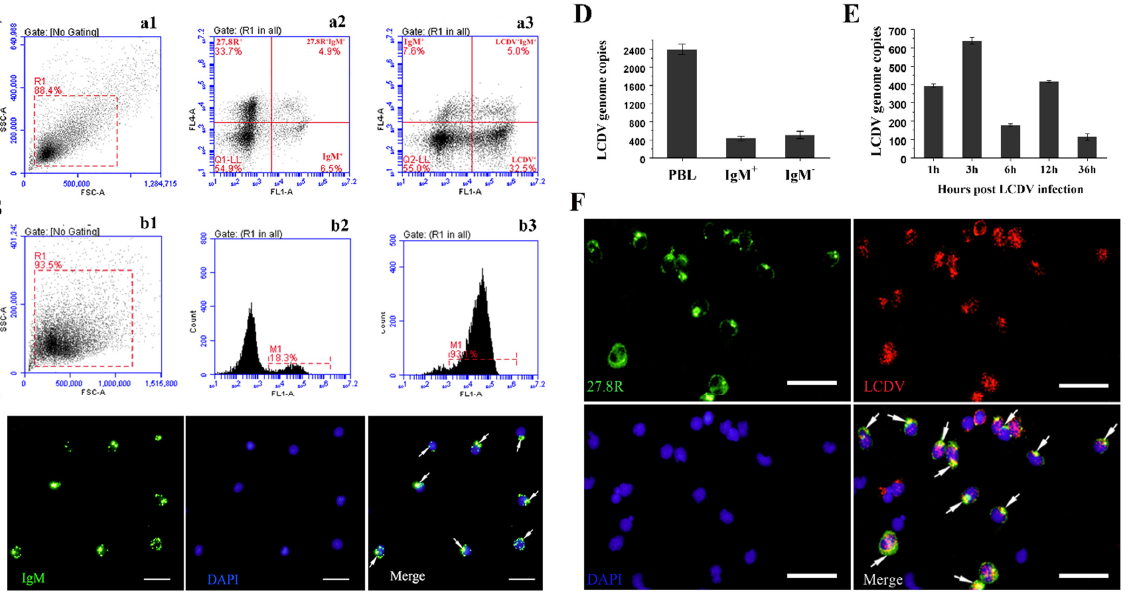
Figure 6. Flow cytometry analysis of 27.8R + /IgM + and LCDV + /IgM + cells in PBLs and LCDV detection and co-localization with the 27.8R in the sorted IgM + B-lymphocytes of flounder. ( A ) Flow cytometry analysis showed the PBLs gated on a FS/SS dot plot ( a1 ), the 27.8R + /IgM + double positive and LCDV + /IgM + double positive PBLs ( a3 ). ( B ) FACS analysis showed the PBLs gate on a FS/SS dot plot ( b1 ), IgM + B-lymphocytes in PBLs before sorting ( b2 ), and the sorted IgM + B-lymphocytes ( b3 ). M1: the ratio of IgM + B-lymphocytes ( b2 ), and the purity of IgM + B-lymphocytes ( b3 ). ( C ) The immunofluorescence staining of the sorted IgM + B-lymphocytes. ( D ) The LCDV copy numbers in PBLs, the sorted IgM + B-lymphocytes, and IgM + B-lymphocytes-depleted (IgM − ) PBLs at 3 hpi. Error bars represented SD ( n = 3). ( E ) The LCDV copy numbers in sorted IgM + B-lymphocytes at different time points post LCDV infection of flounder. Error bars represent SD ( n = 3). ( F ) The co-localization of the 27.8R and LCDV in the sorted IgM + B-lymphocytes. Scale bar = 10 μ m.